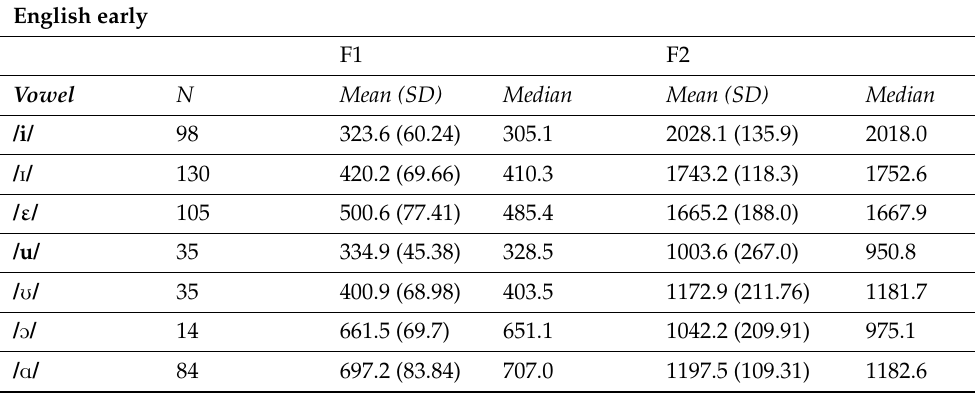
Table A2. Means, standard deviations and medians of F1 and F2 (reported in Hertz) obtained for AS’s English and German monophthongs across different stages in time, including the number of tokens (N) measured for each monophthong according to language and